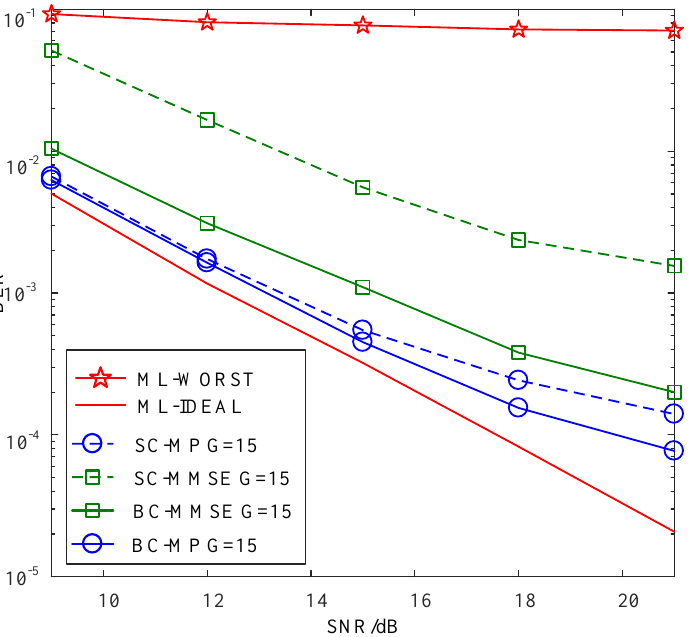
Figure 10. BER comparisons of the proposed SC-MMSE, SC-MP, BC-MMSE, and BC-MP detectors for the GSTFIM systems with G = 15, N t = 2, and N r = 2 in three